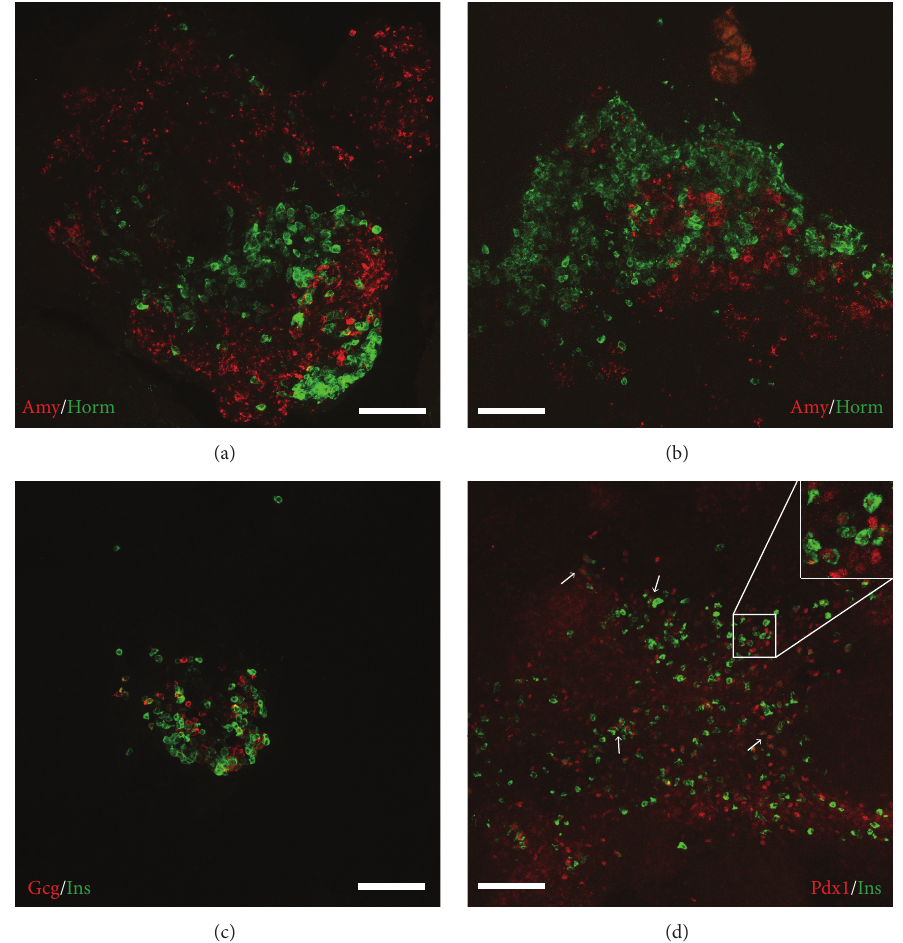
Figure 8: High magnification images of Suspension-DE Dox cultures. (a, b) Horm + and Amy + cells are intermingled with each other. In particular amylase and hormone expression are cytoplasmic and do not overlap. (c) Insulin + cells are mostly monohormonal but comingled with glucagon + cells. (d) Insulin + cells express PDX1 in the nucleus. Inset shows higher magnification to indicate nuclear PDX1 in insulin + cells. Arrows point to many insulin + cell clusters that have nuclear PDX1. Scale bars, 50 𝜇